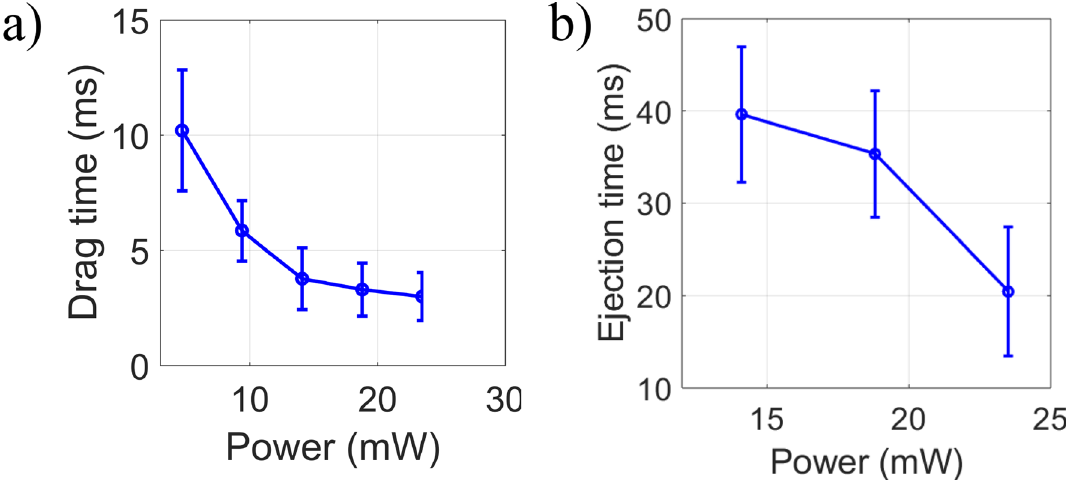
Figure 3. ( a ) Drag, and ( b ) ejection times for the second particle against average power under pulsed